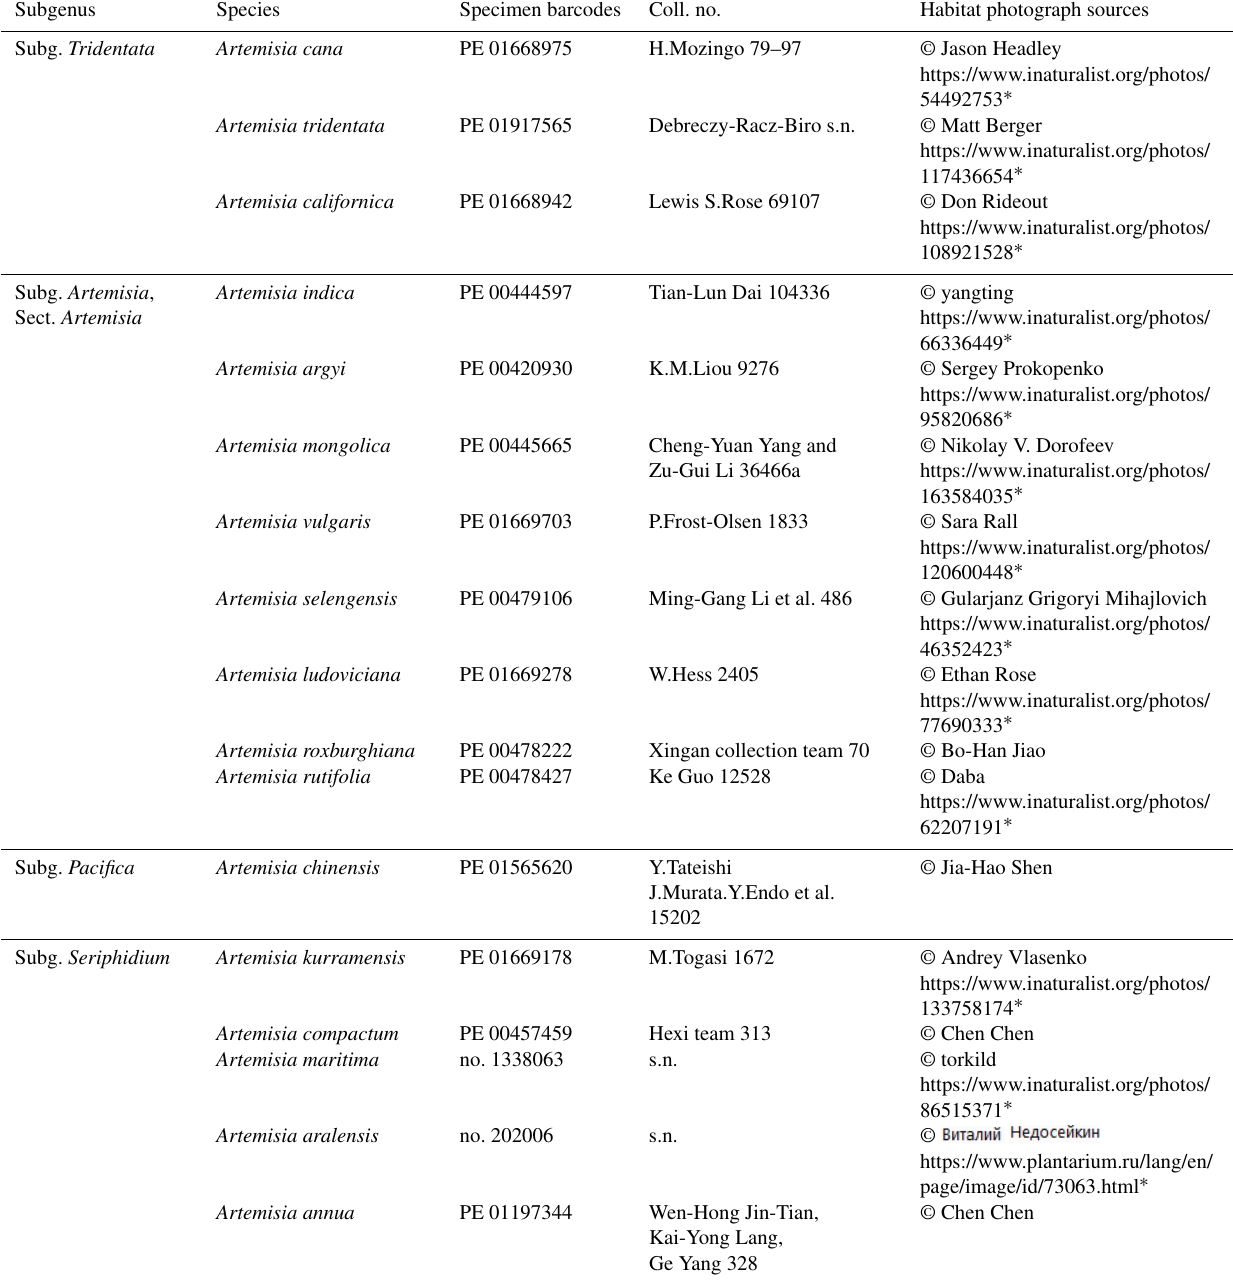
Table B1. List of the voucher specimen in PE Herbarium, Institute of Botany, Chinese Academy of Sciences.